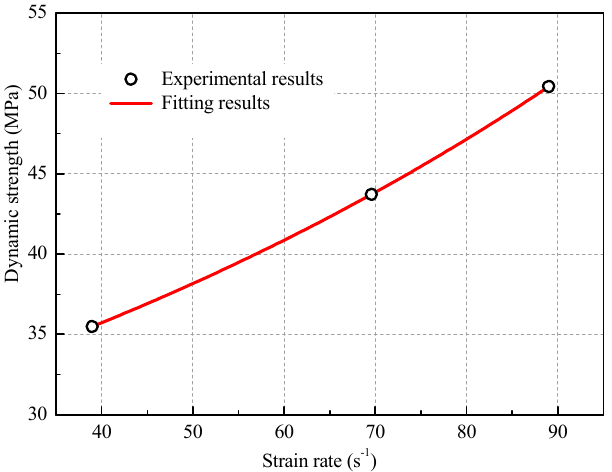
Figure 9. Variation of dynamic strength with strain rate.